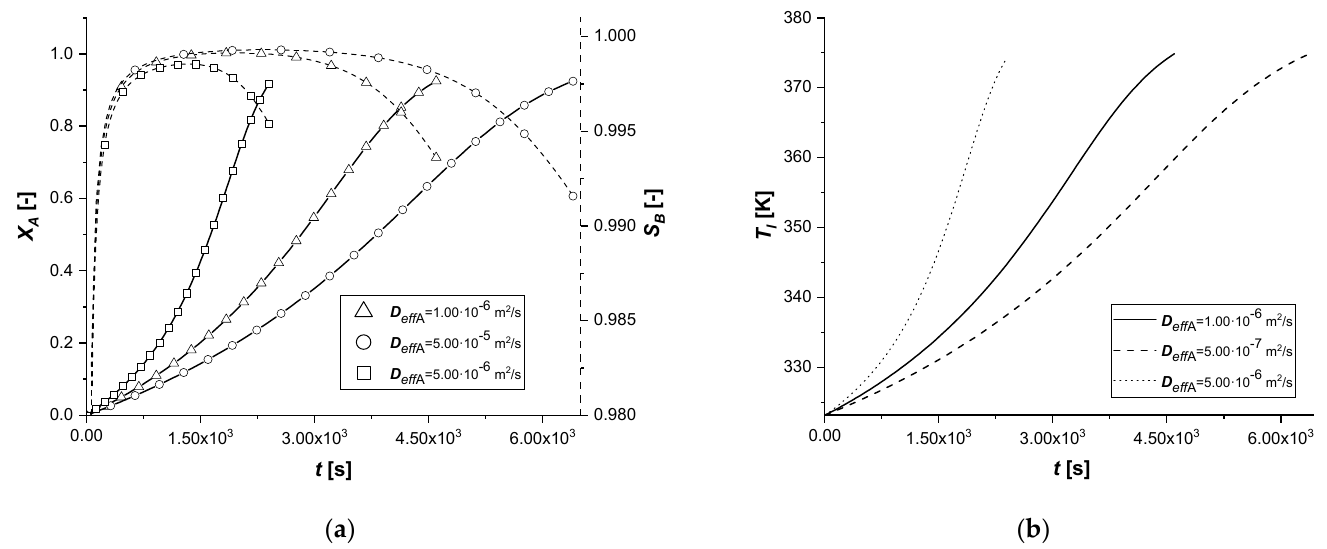
Figure 17. ES D eff,A investigation. ( a ) Bulk profiles over time of X A and S B . ( b ) Bulk profile of T l over time.